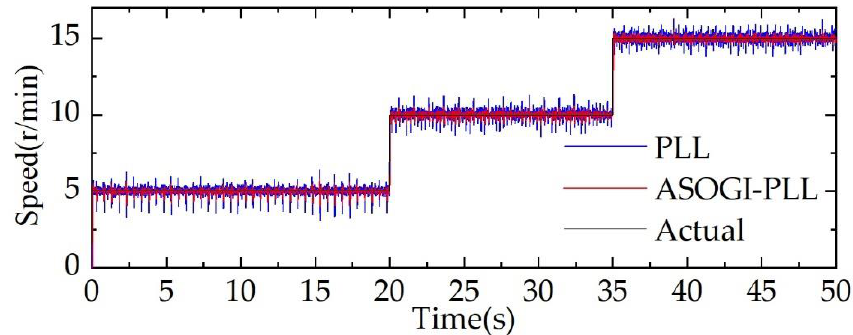
Figure 11. Speed waveform at speed up.